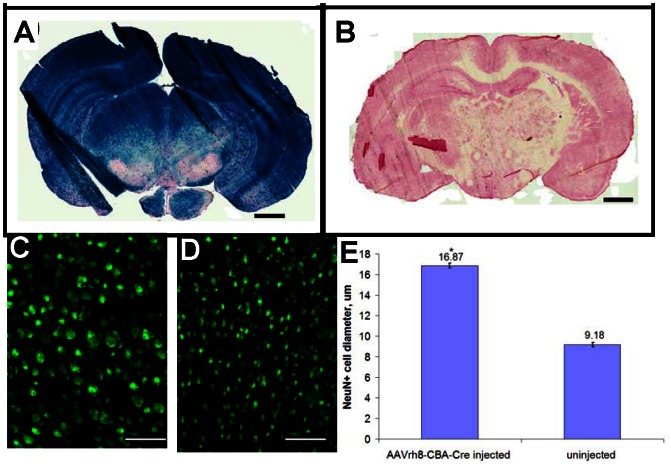
Cre-mediated recombination in Tsc1c/c mice after injection of AAVrh8-CBA-Cre at birth.In Tsc1c/c mice, Cre-mediated recombination knocks-out the floxed Tsc1 allele and knocks-on a transgenic lacZgene. These mice were injected at P0 with AAV8-CBA-Cre vector (2×1010g.c. in each ventricle), and lacZ expression throughout the brain was analyzed at ∼P28 as a marker of recombination efficiency. (A) AAV-treated Tsc1c/cROSA mice displayed intense lacZ expression throughout the brain, (B) while uninjected controls were devoid of any lacZ activity. Ten µm sections were stained with X-gal solution and counterstained with Nuclear Fast Red. Scale bars: 1 mm. (C & D) Staining for NeuN shows that neurons above the lateral ventricles in AAVrh8-CBA-Cre injected mice were considerably larger than in control uninjected mice Scale bars: 200 µm. (E) The periventricular neurons of the brains of AAV-Cre injected and non-injected mice (P28) were immunostained for the neuronal marker, NeuN and the widest diameter of stained cell bodies was measured in >180 randomly selected cells from several fields with 3 animals per group. The AAV-Cre injected cortical neurons had an almost 2-fold increase in diameter, shown as mean±SEM (*p<0.001).